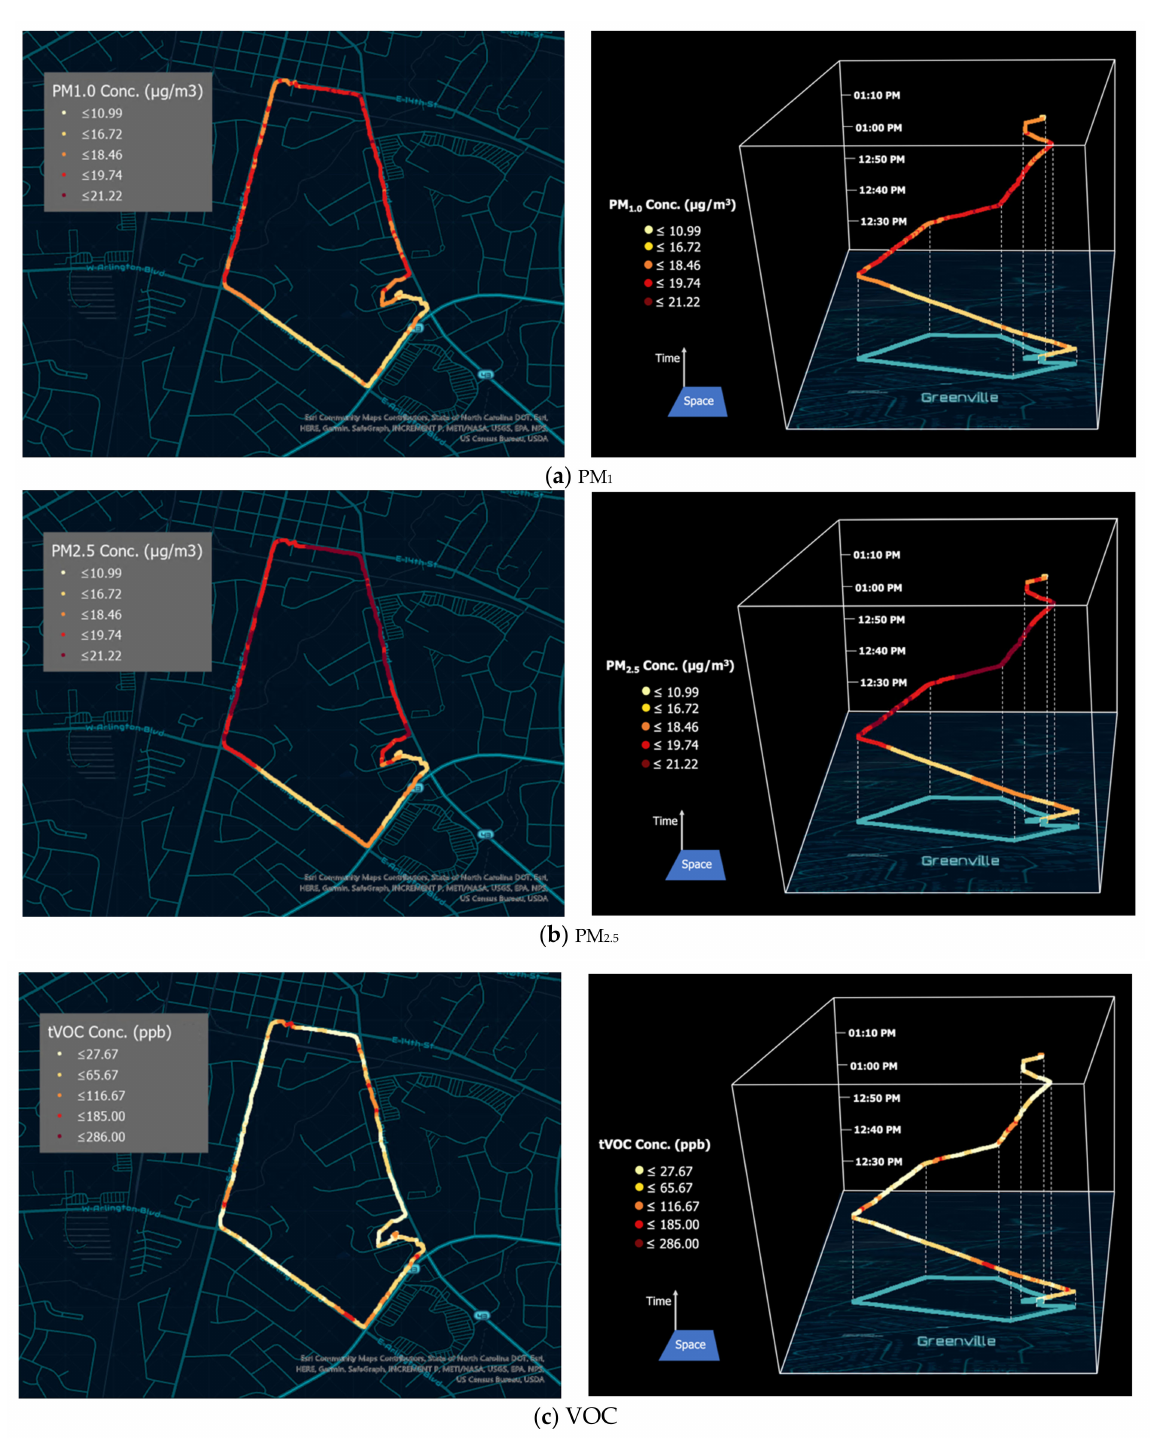
Figure 6. Visualizations of georeferenced air quality data obtained from